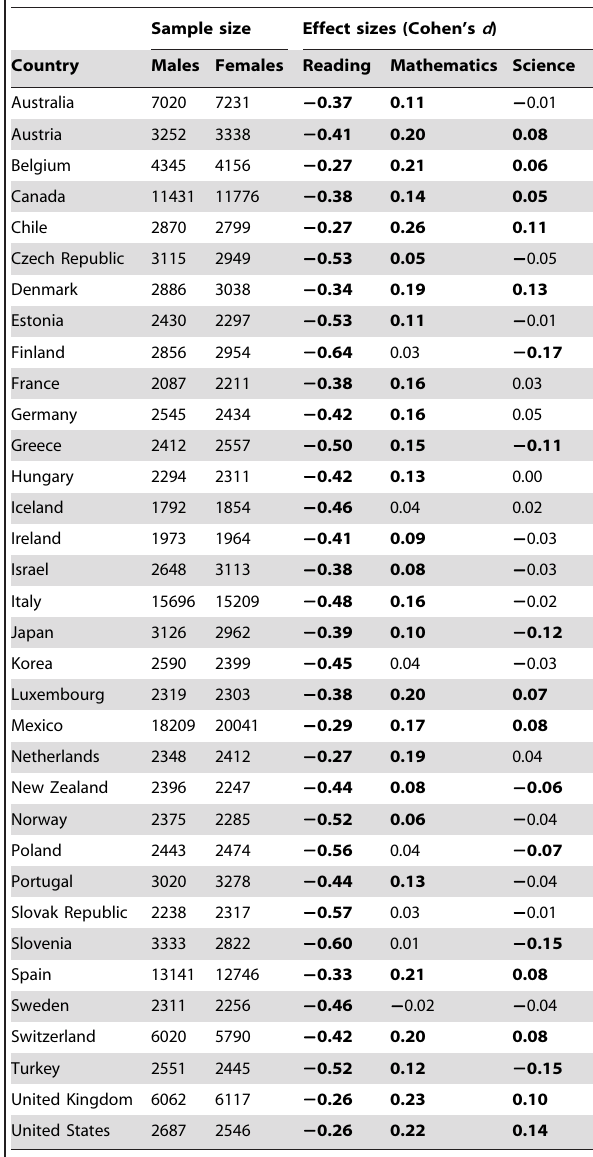
Table 4. National Gender Differences in Reading, Mathematics, and Science Literacy for PISA Partner Countries. Sample size Effect sizes (Cohen’s d